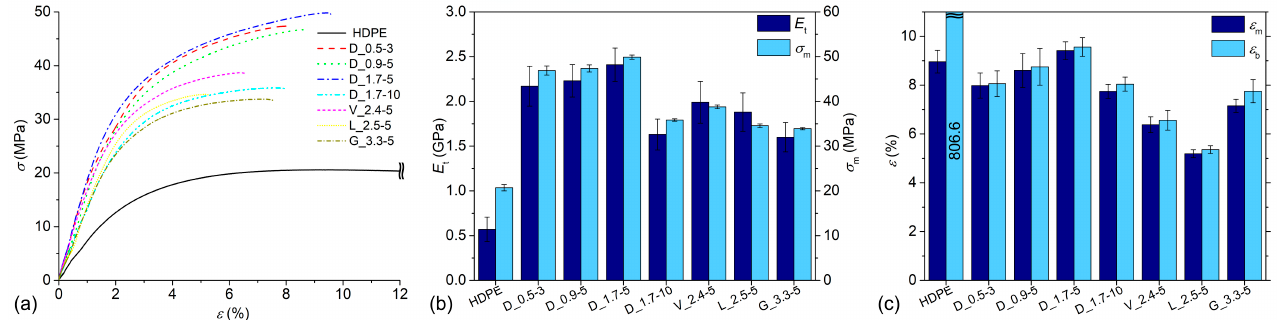
Figure 5. Tensile properties of samples: ( a ) stress–strain curves; ( b ) modulus and strength; ( c ) strain at break and strain at strength.